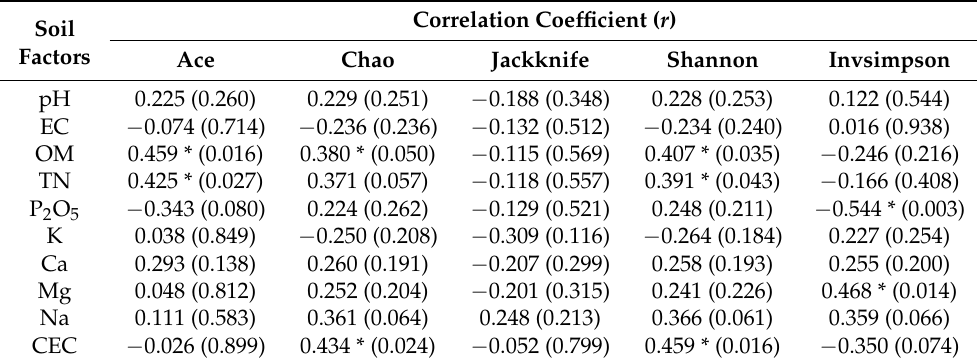
Correlation coefficients ( r ) are significantly correlated between the variables compared. Negative values denote negative correlation, and positive values denote positive correlation. Values in parentheses refer to p -values (* p <